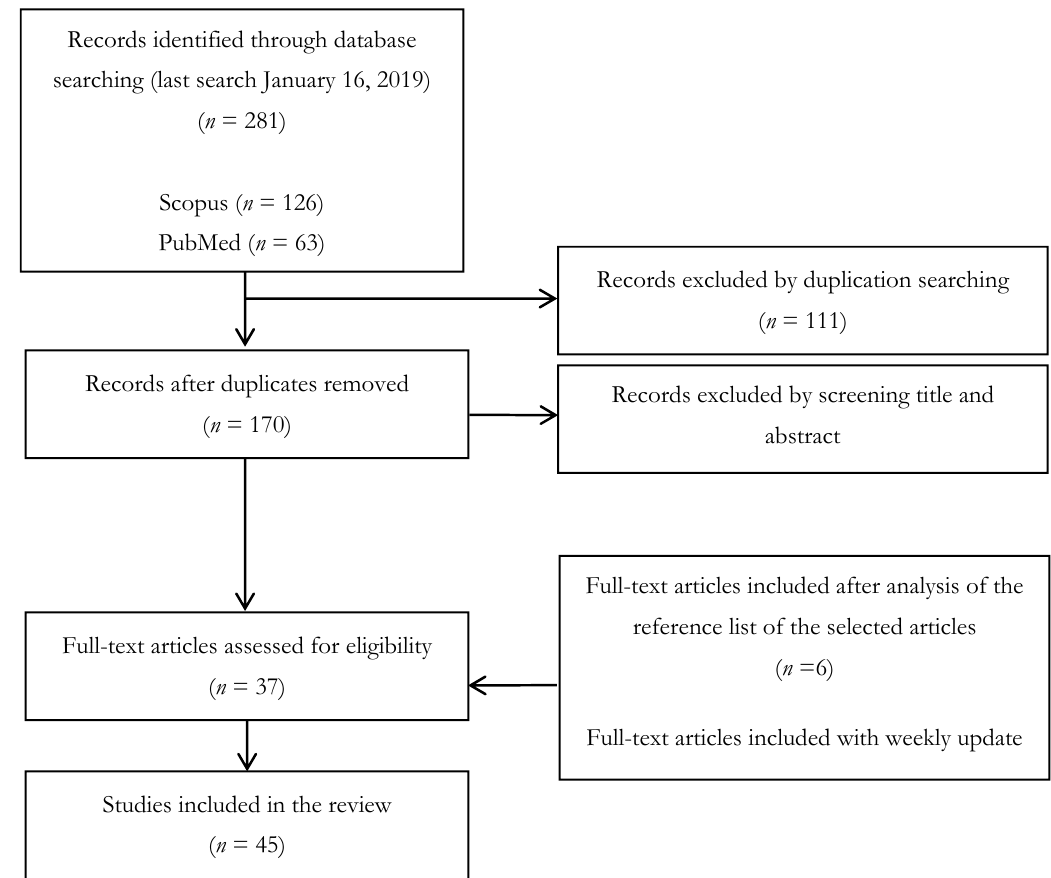
Figure 1. Flowchart of literature searched and reviewed, modified from Moher et al., 2009 [10].